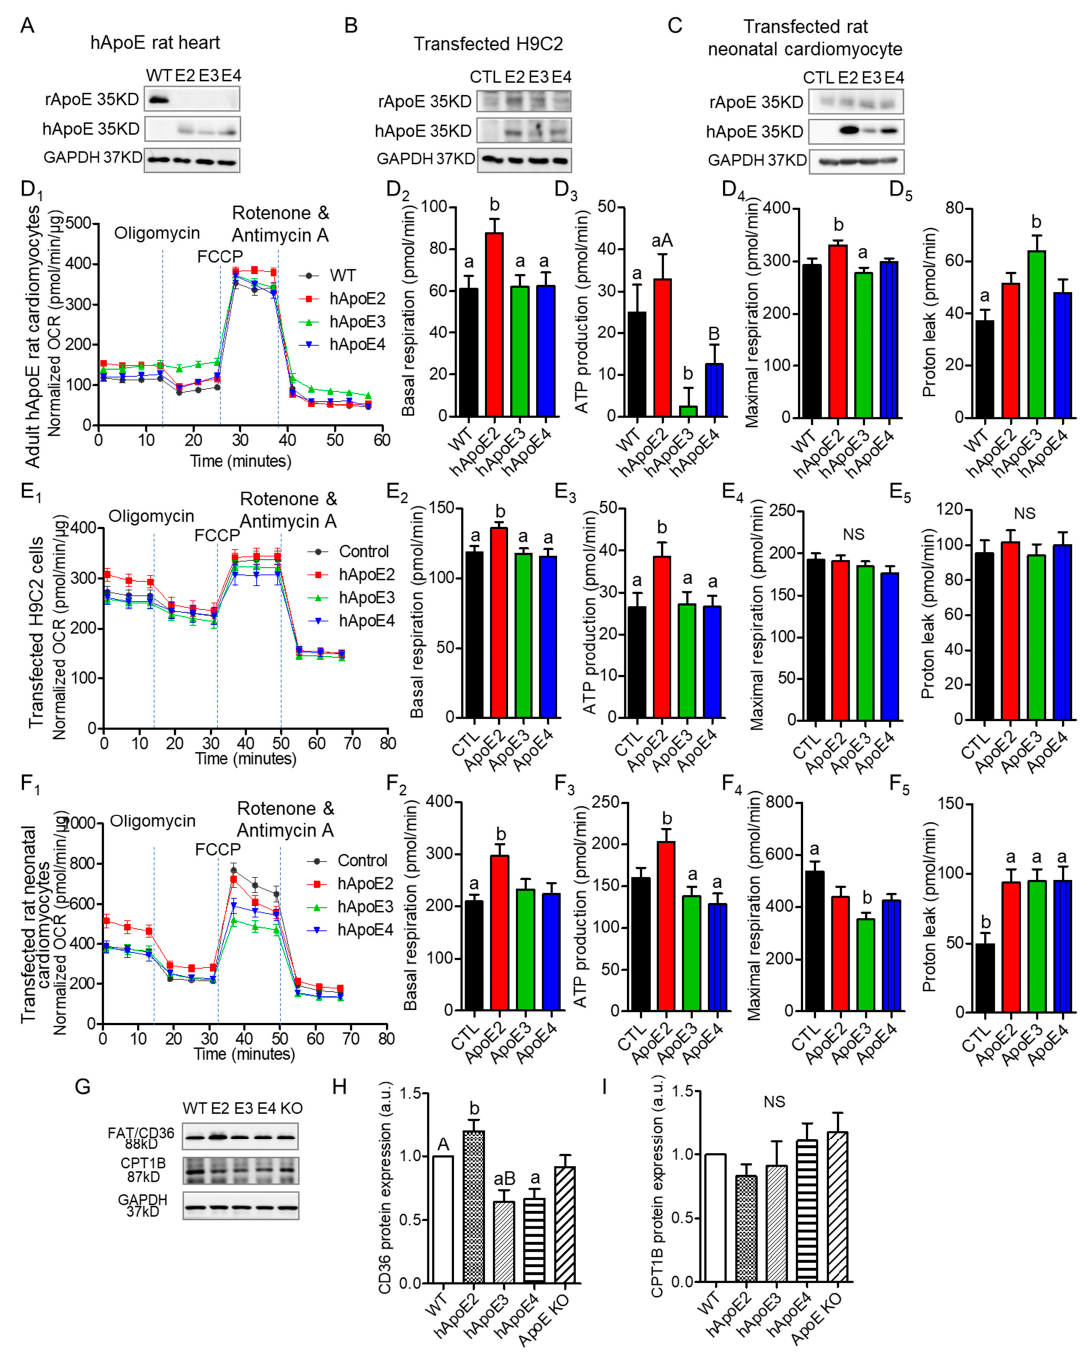
Figure 4. ApoE2 expressing cardiomyocytes exhibited elevated energy production through mitochondrial respiration/fatty acid β -oxidation. Western blotting detected the protein expression levels of rat ApoE (anti-rApoE) and human ApoE (anti-hApoE) in heart lysate of adult rats ( A ), H9C2